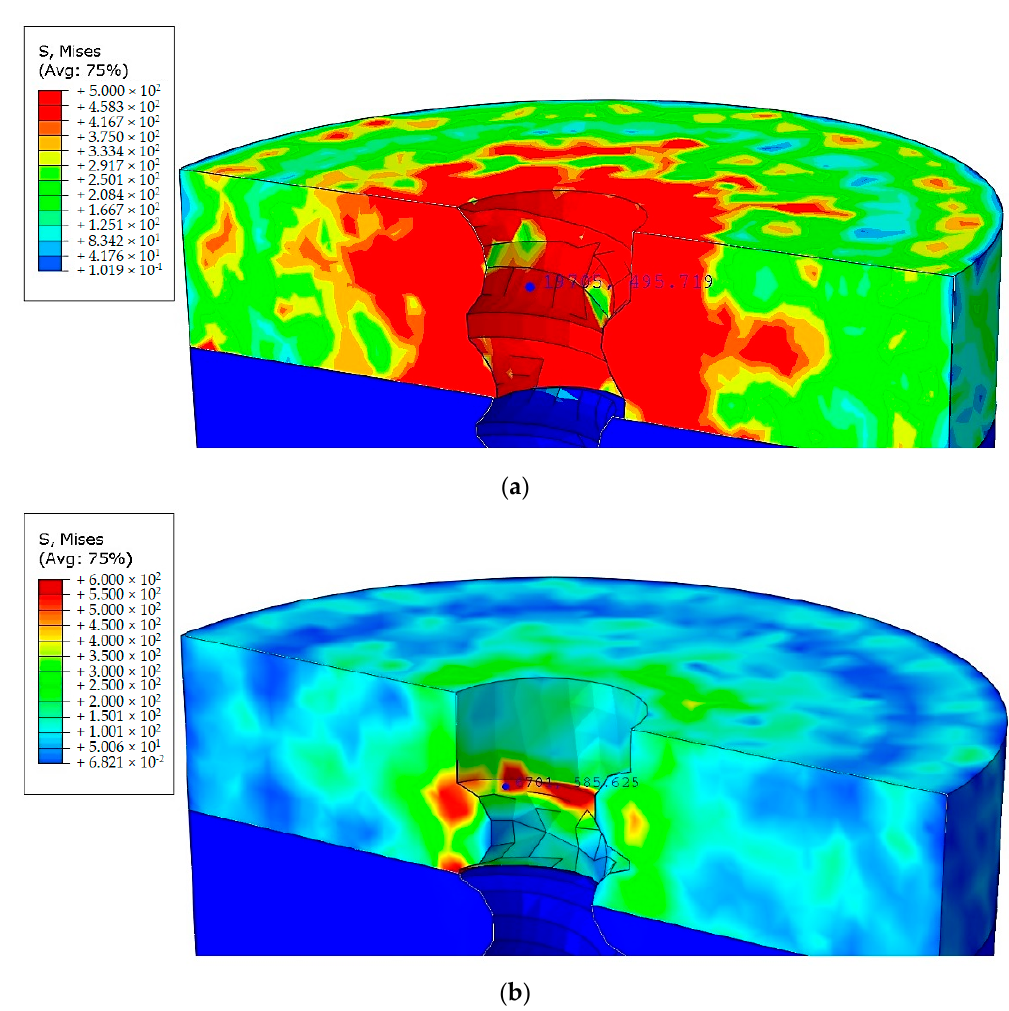
Figure 7. Von Mises stress generated on the cortical bone ( a ): Thomas ® -pin and ( b ): Perfect Anchor.